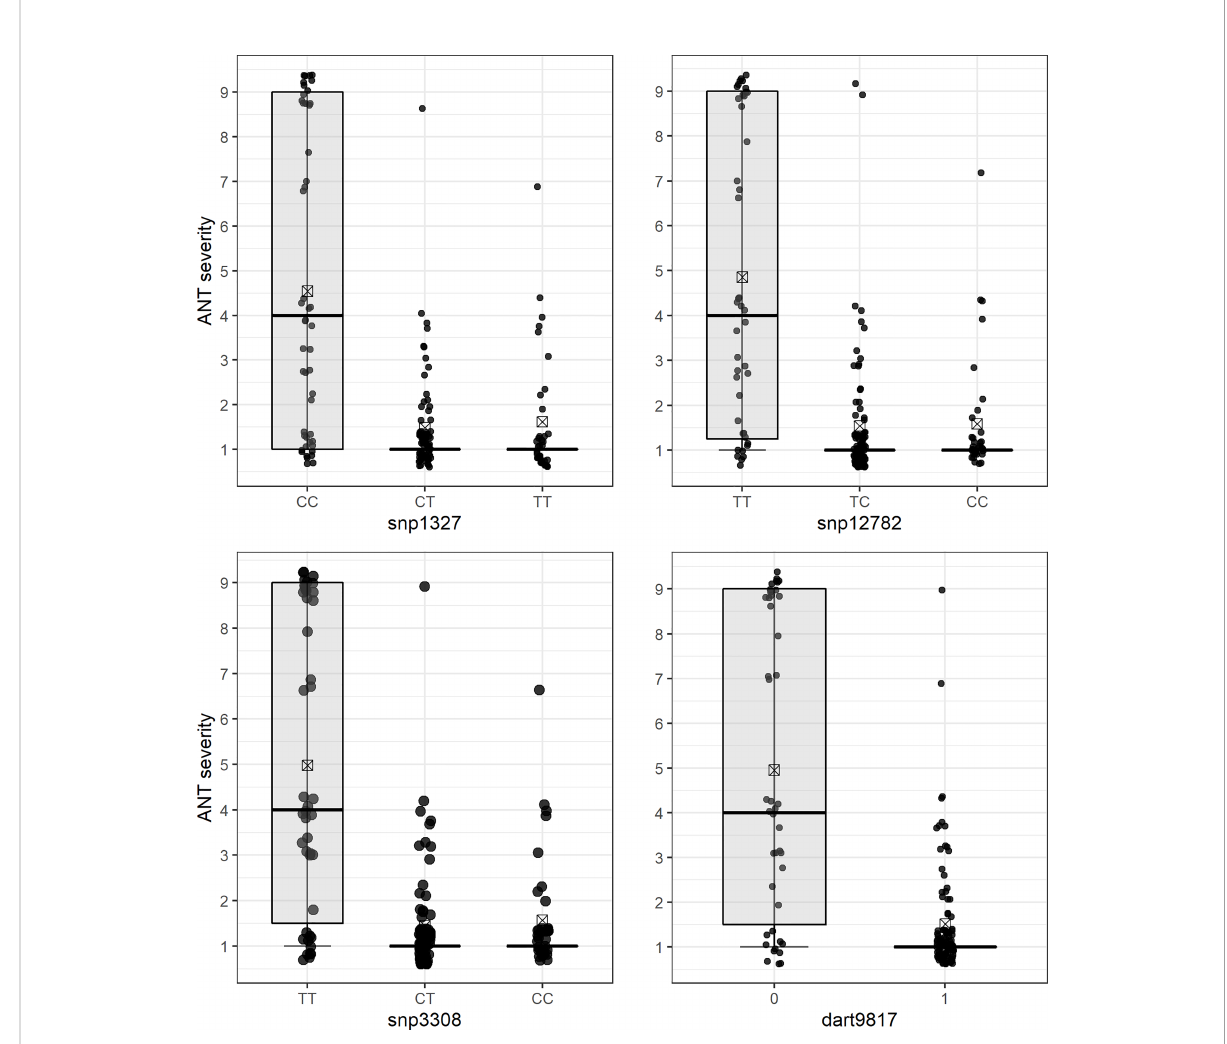
FIGURE 2 Differential reaction of F 2 (BRSMG Realce × BRS FC104) plants to Colletotrichum lindemuthianum race 475 for each molecular genotype class of SNP markers fl anking the Co-Realce genomic region: snp1327 (CC, CT and TT), snp12782 (TT, TC and CC), snp3308 (TT, CT and CC) and dart9817 (0 and 1). The mean phenotypic scores are represented by a rectangle inside each box